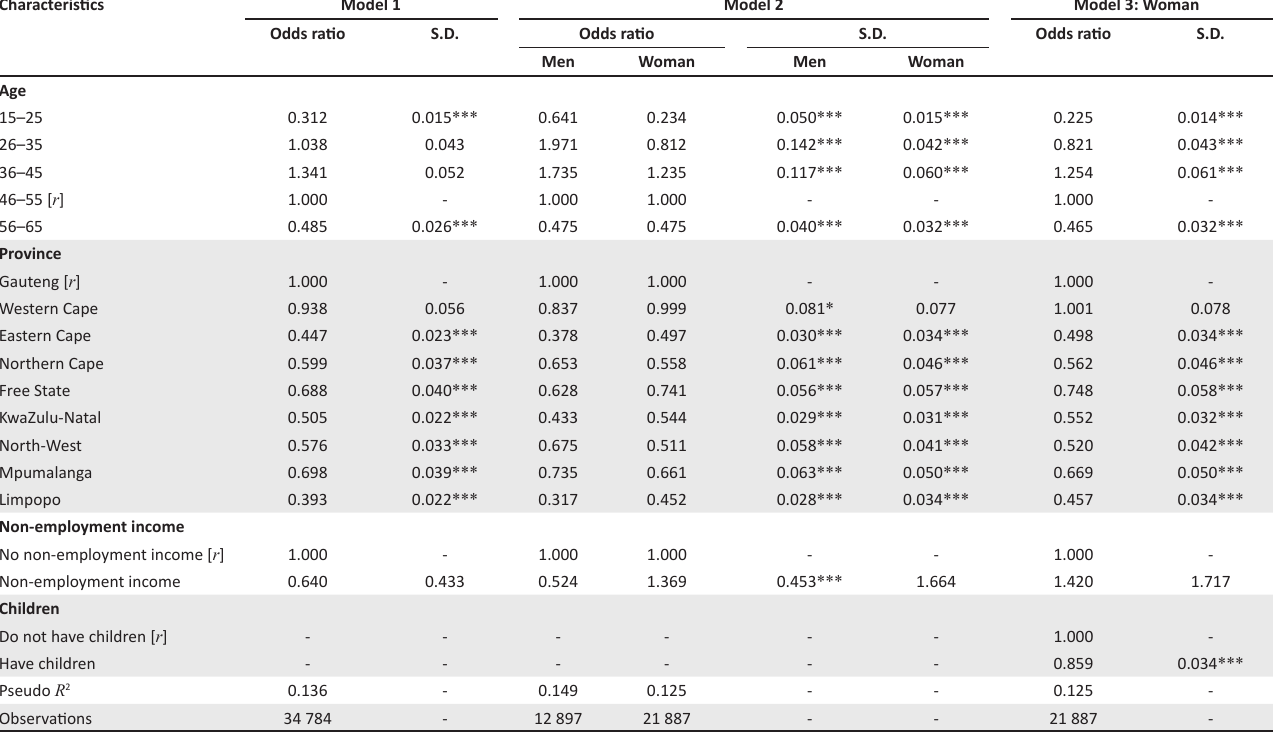
TABLE 6 (Continues...): Employment logistic regression results.